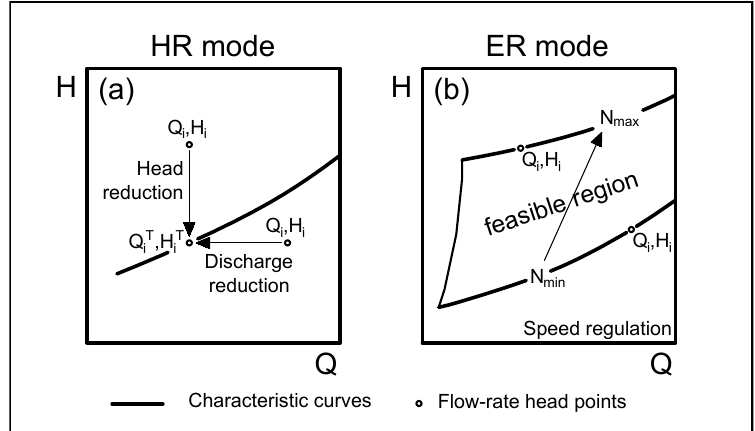
Figure 2. Pump as turbine (PAT) operating conditions in ( a ) hydraulic; or ( b ) electrical